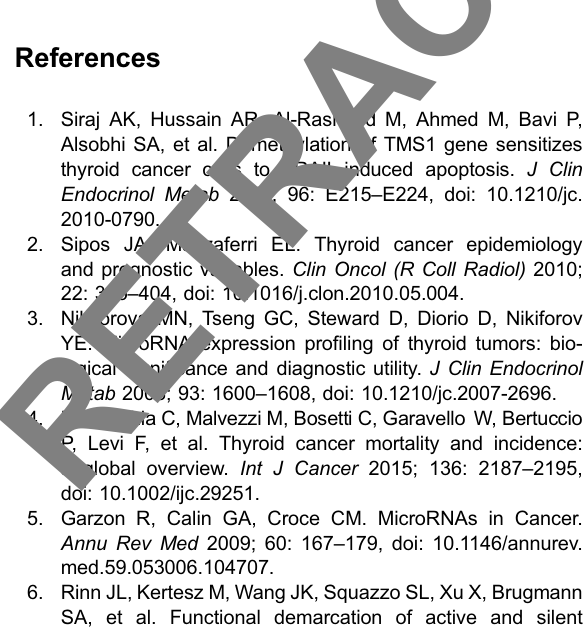
Figure 6. CCAT1 activated PI3K/AKTand MAPK signaling pathways via the inhibition of miR-143. FTC-133 cells were transfected with CCAT1 expressing vector, CCAT1 shRNA, miR-143 mimic, or miR-143 inhibitor. The expressions of the main factors in A , PI3K/AKTand B , MAPK signaling pathways were analyzed in FTC-133 cells using western blot analysis. NC: negative